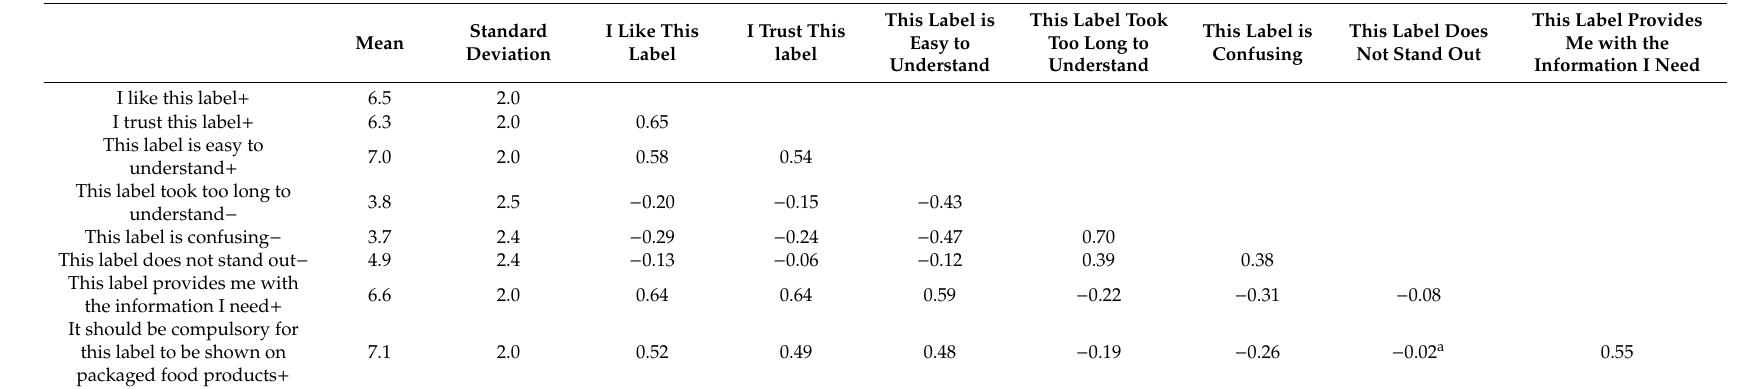
Table 2. Means, standard deviations and Pearson correlation coe ffi cients between the perception